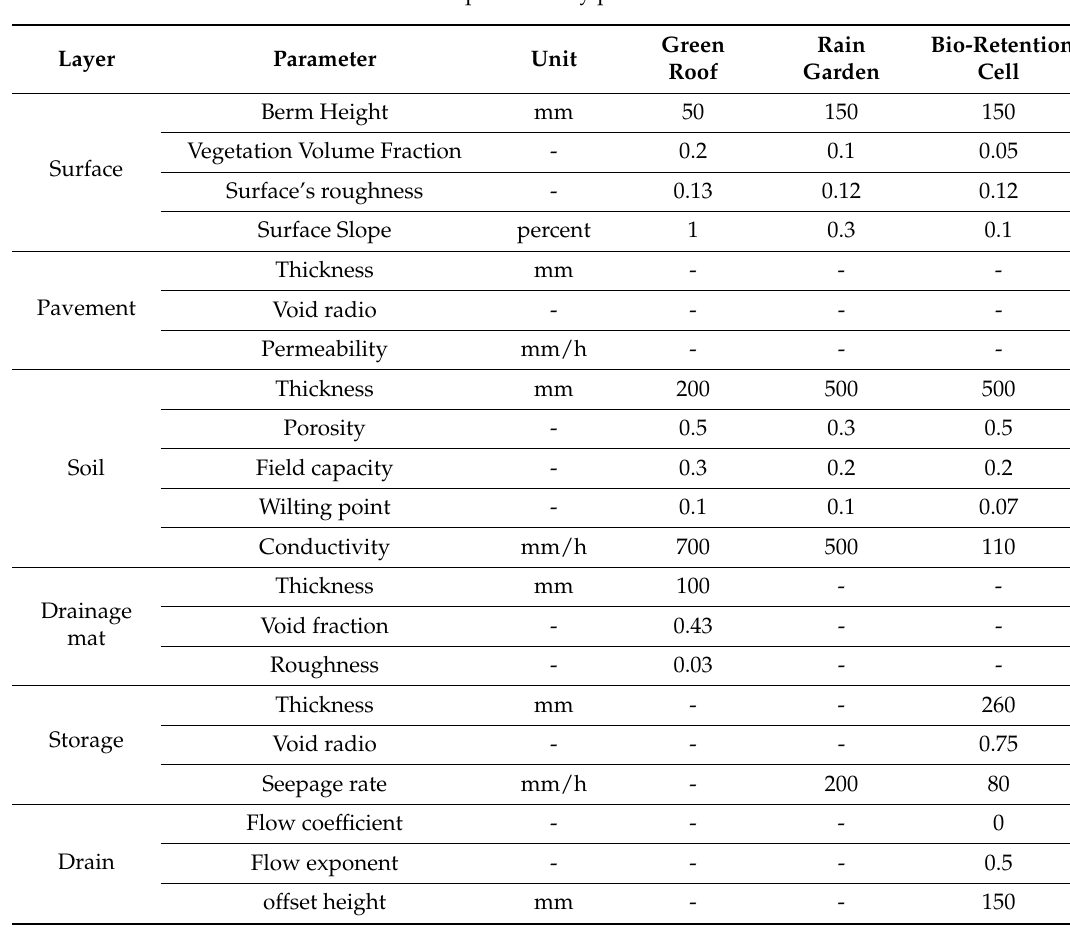
Table 6. Partial permeability parameters of